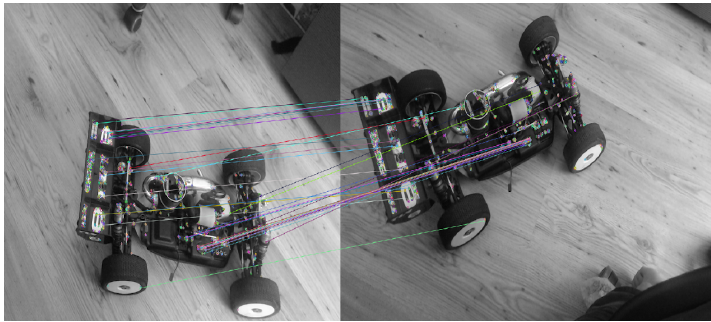
Figure 13. Good initial